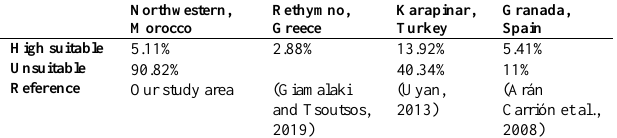
Table10. Results obtained by FAHP compared with others obtained with AHP published in mediterranean data. Northwestern,